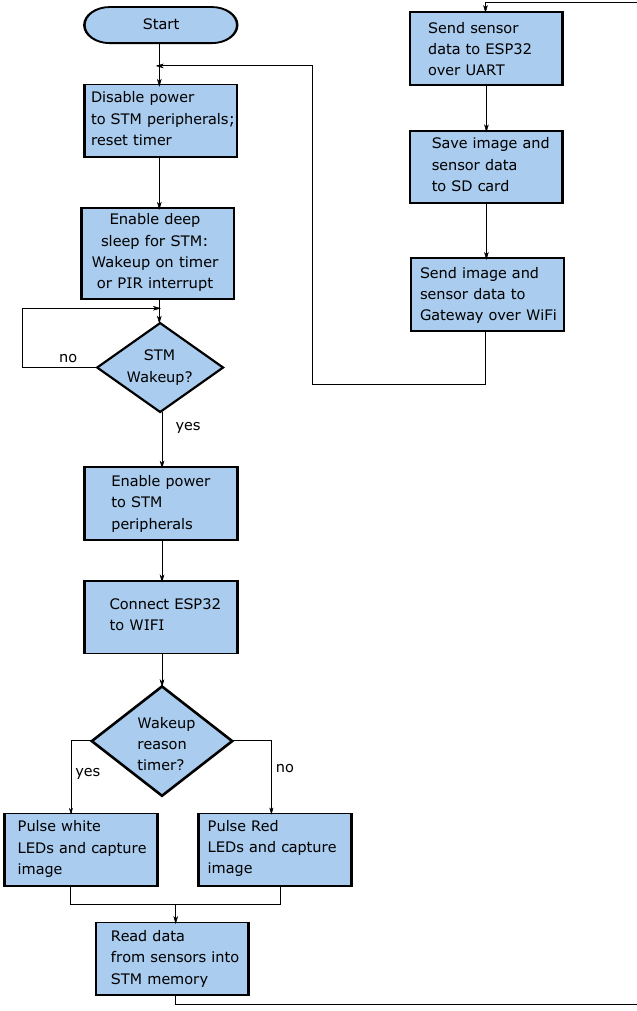
Figure 4. Flowchart for Ratspy Client